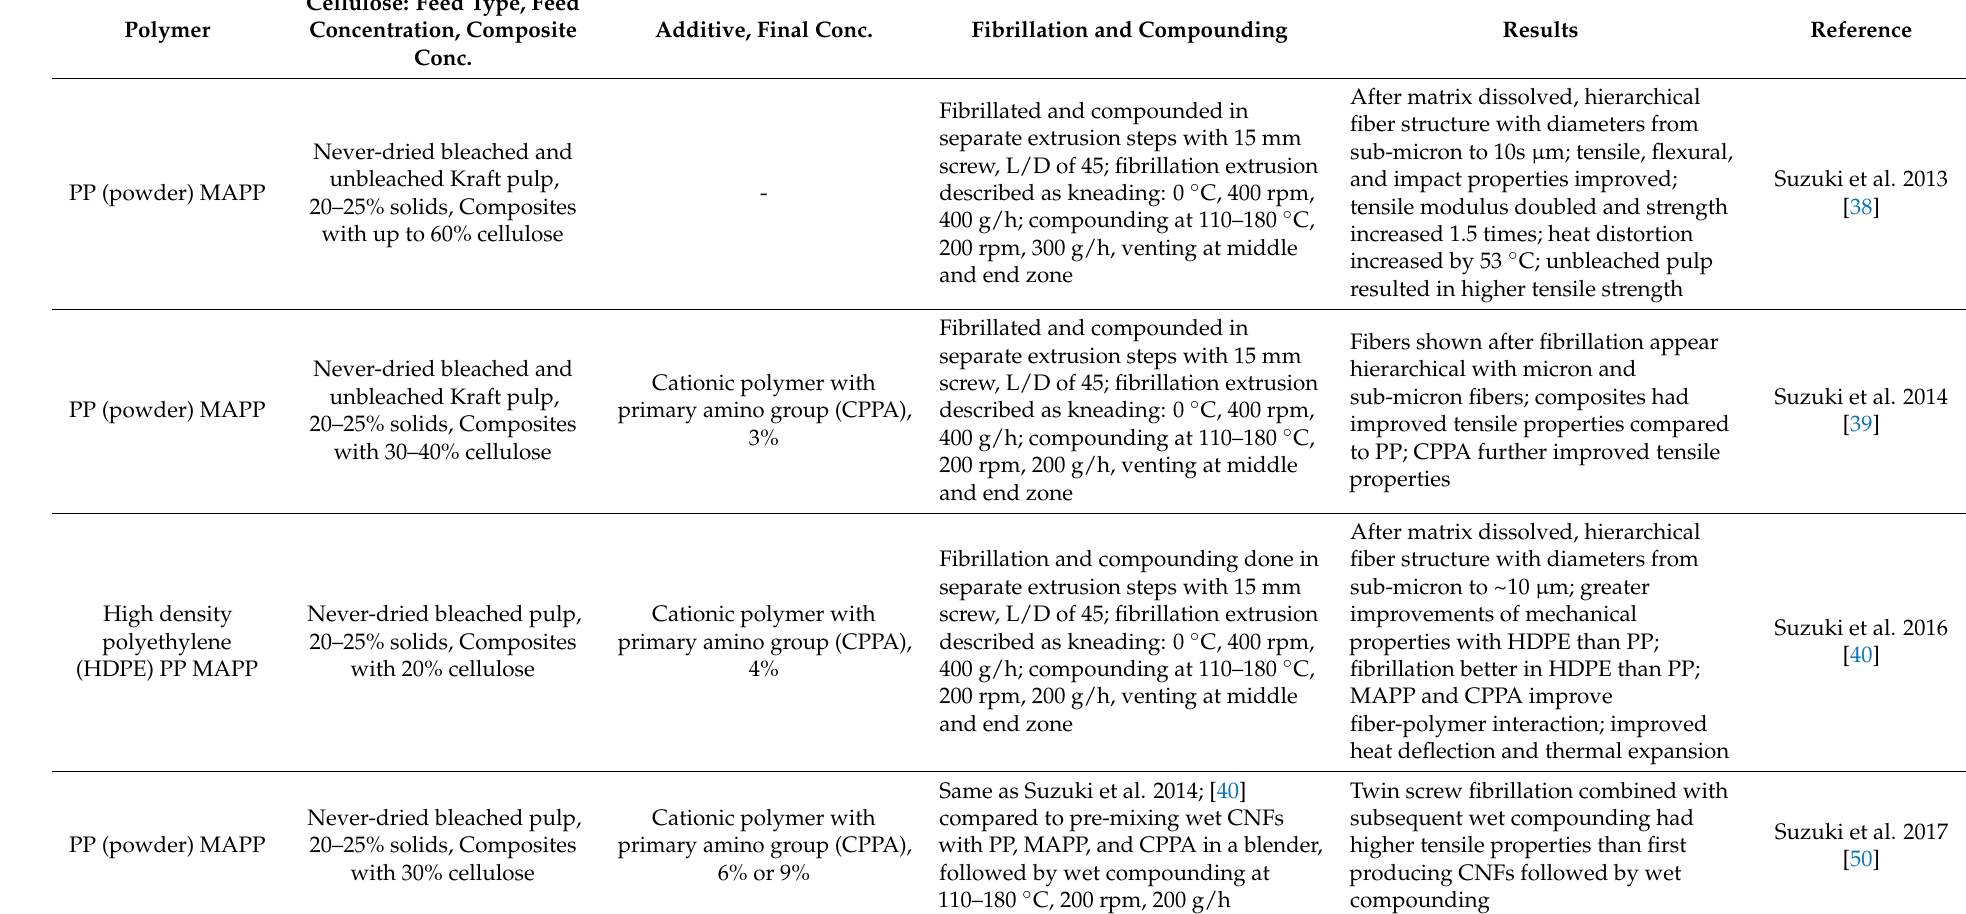
Table 4. Cellulose composites produced by extrusion fibrillation and wet extrusion